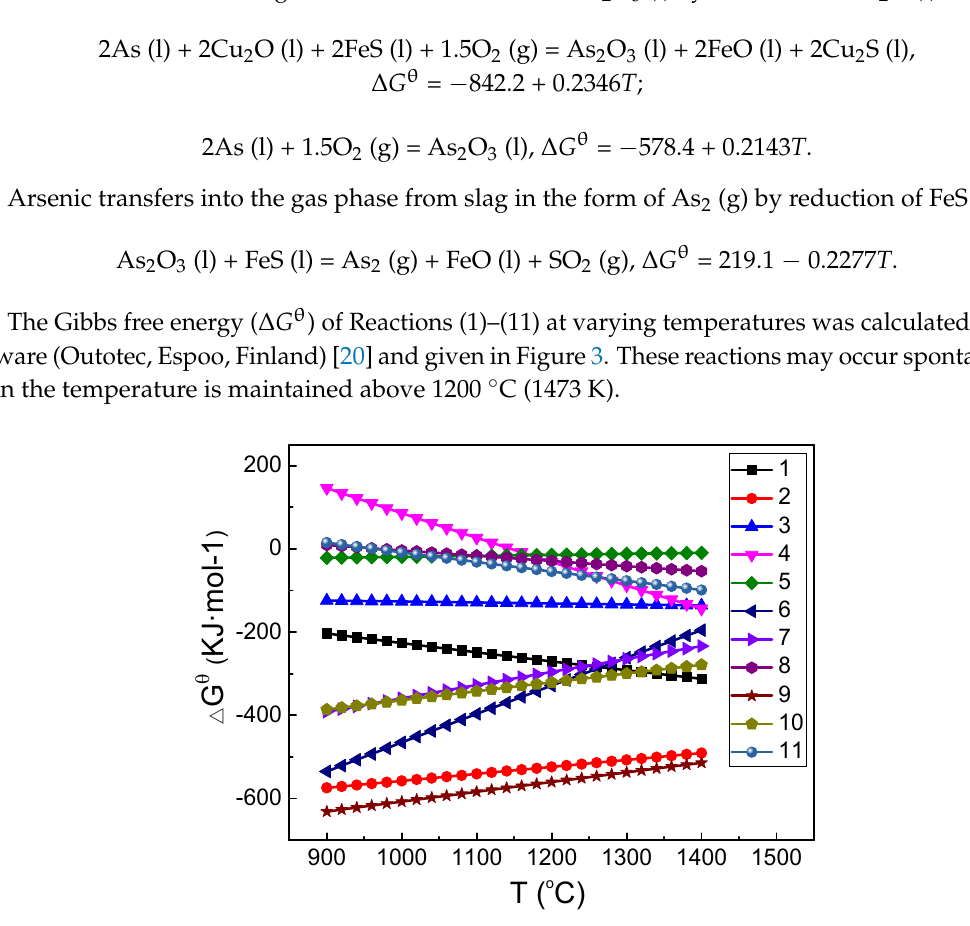
Figure 3. Relationships between Δ G θ (kJ ∙ mol − 1 ) and temperature (°C) of Reactions (1)–(11).